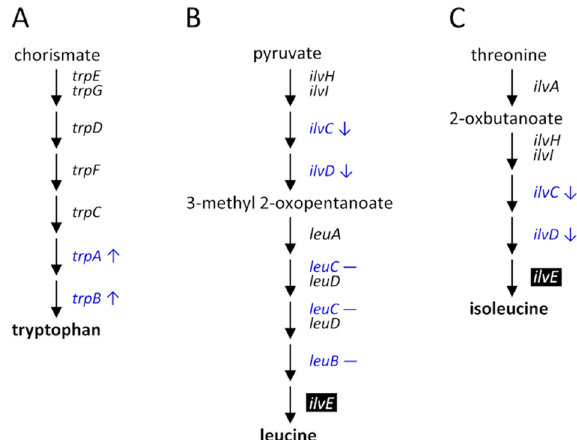
Figure 8. Differential expression of the genes in essential amino acid biosynthesis pathways of P. aleyrodidarum in female B. tabaci reared on cotton plants between the first and the tenth generations: ( A ) tryptophan, ( B ) leucine, and ( C ) isoleucine. Reverse type indicates genes that exist only in B. tabaci and blue font indicates those examined in the present study. Up and down arrows indicate that gene expression was up- and downregulated, respectively, in the tenth generation. Dash indicates no differential expression between the first and the tenth generations.